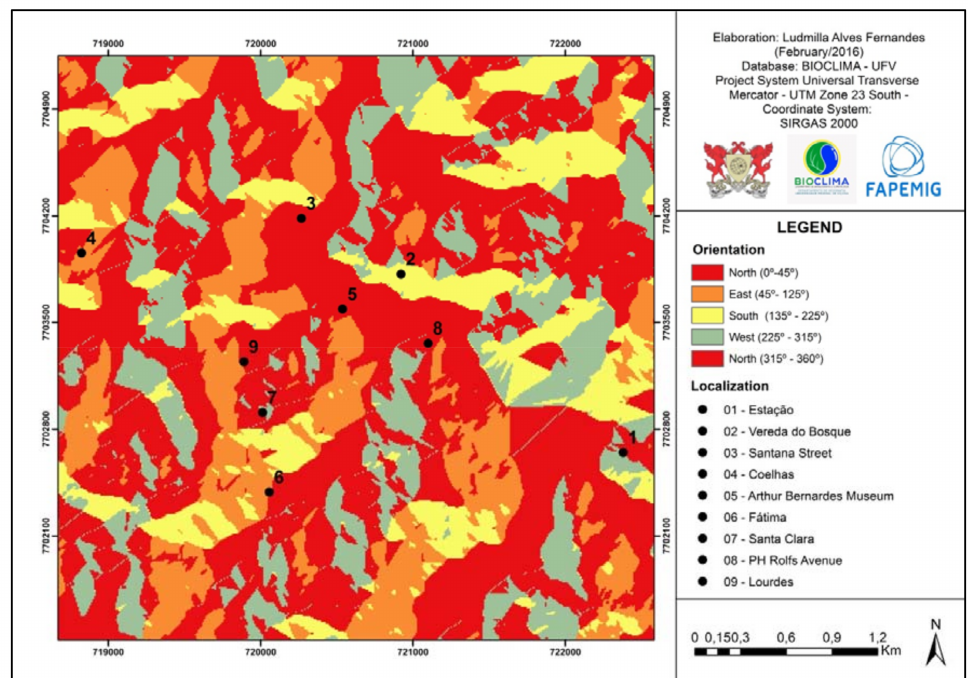
Figure 2. Guidance map of slopes of data collection points in the municipality of Viçosa (MG). Data source: BIOCLIMA—UFV.